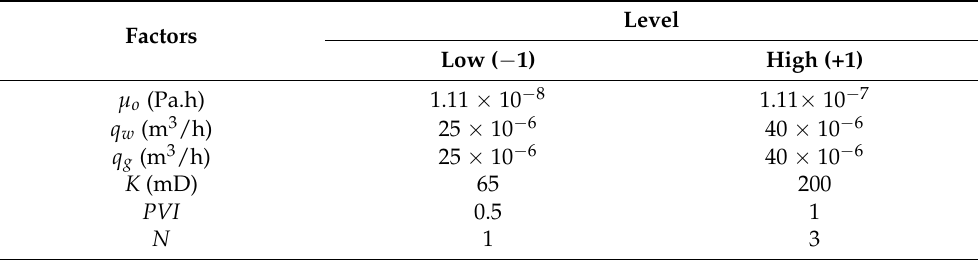
Table 2. Design matrix of factors.